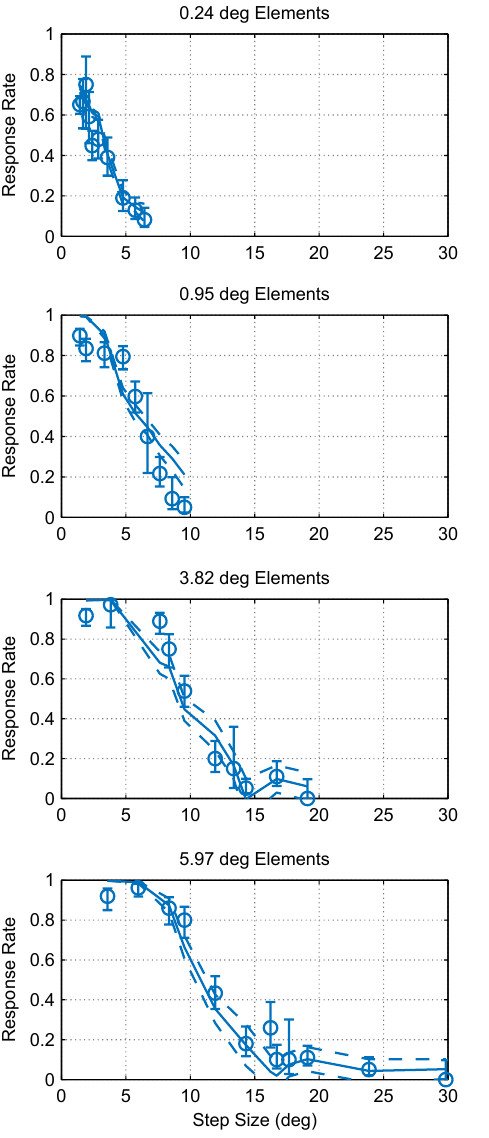
Figure 10. Predictions of Model 2 against experimental results. The mean (solid line) and interquartile range of Model 2 (dashed lines, based on 50 simulated trials per data point), showed good agreement with our experimental observations (symbols, with error-bars showing 95% confidence